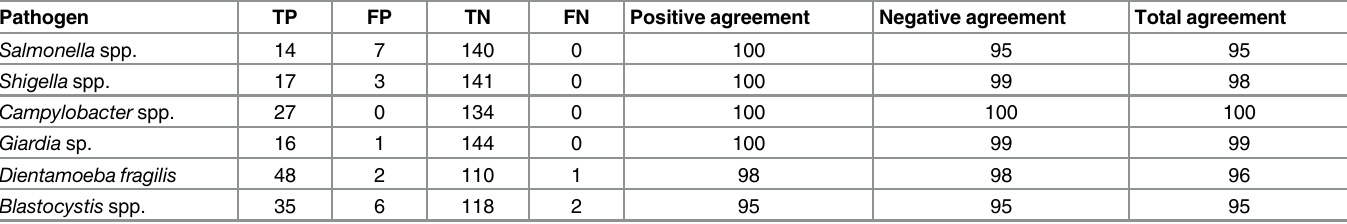
Table 3. Discrepant analysis results following the discrepancies shown in Table 2. TP, True Positives; FP, False Positives; TN, True Negatives; FN, False Negatives. According to statistical analysis (Fisher exact test) the results are in concordance (p < 0.0001).